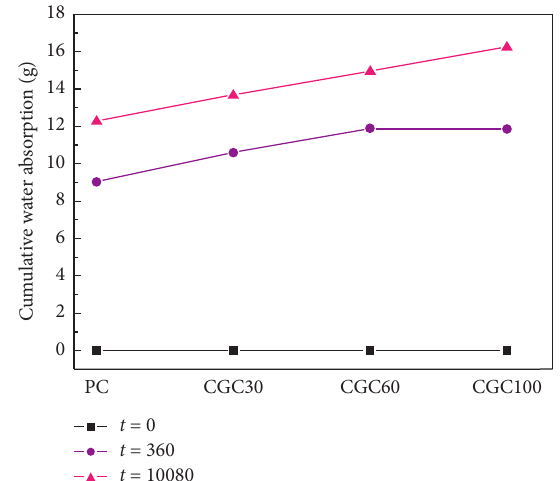
Figure 5: Effect of coal gangue ceramsite on cumulative water absorption of